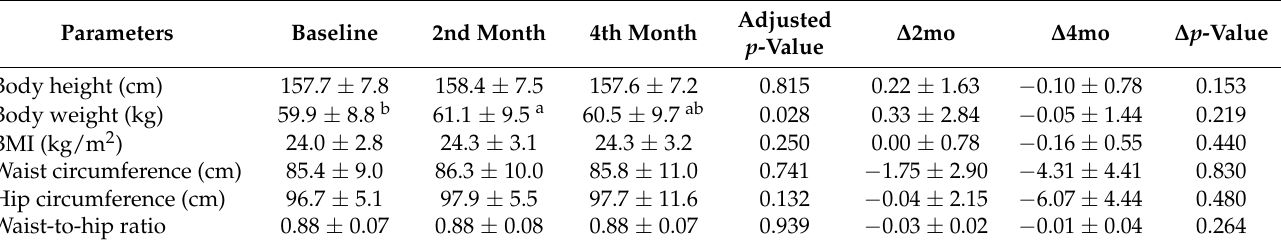
Table 1. Anthropometric measurements.